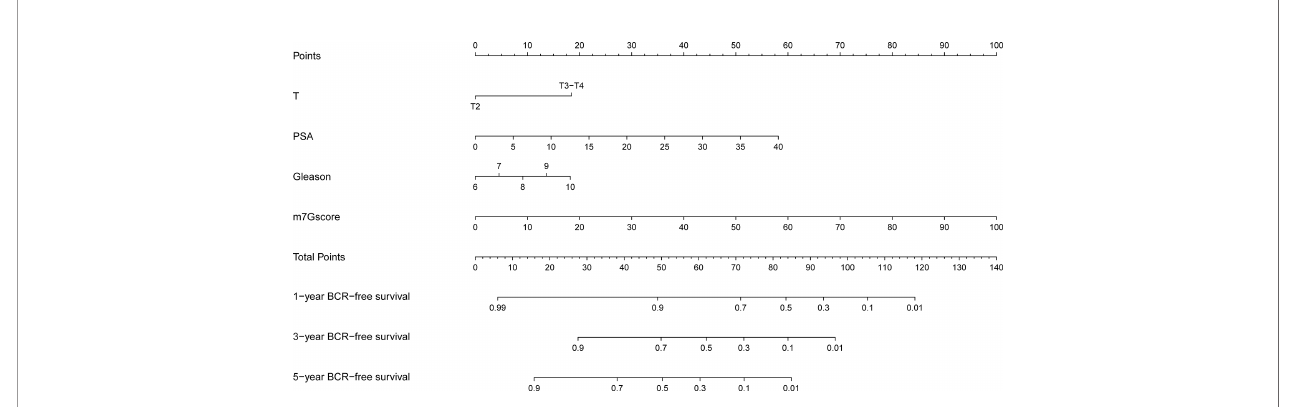
FIGURE 6 | Development of the nomogram model.